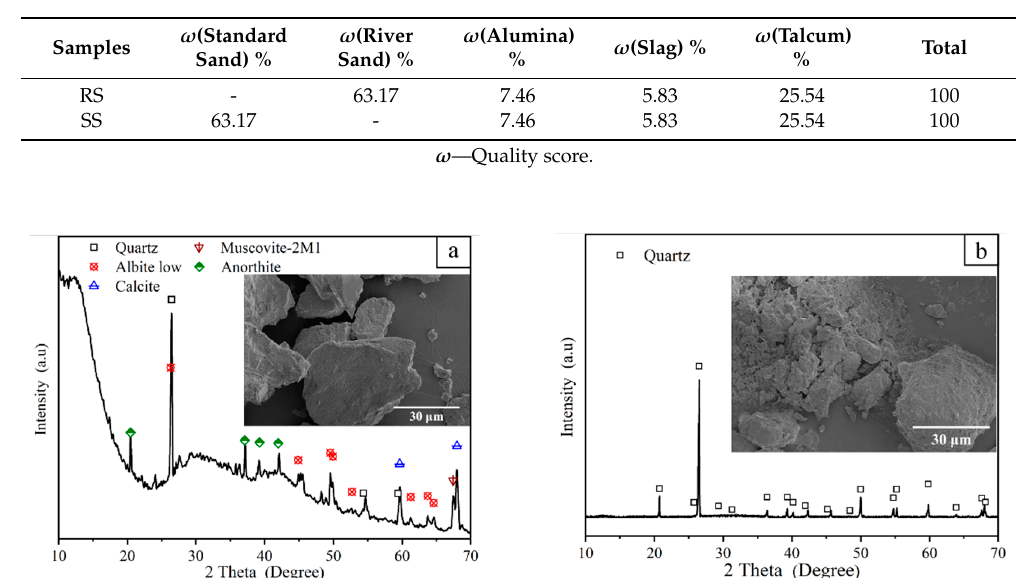
Figure 1. SEM (Scanning electron microscope) image and XRD (X-ray diffraction) pattern of ( a ) river sand and ( b ) standard sand.